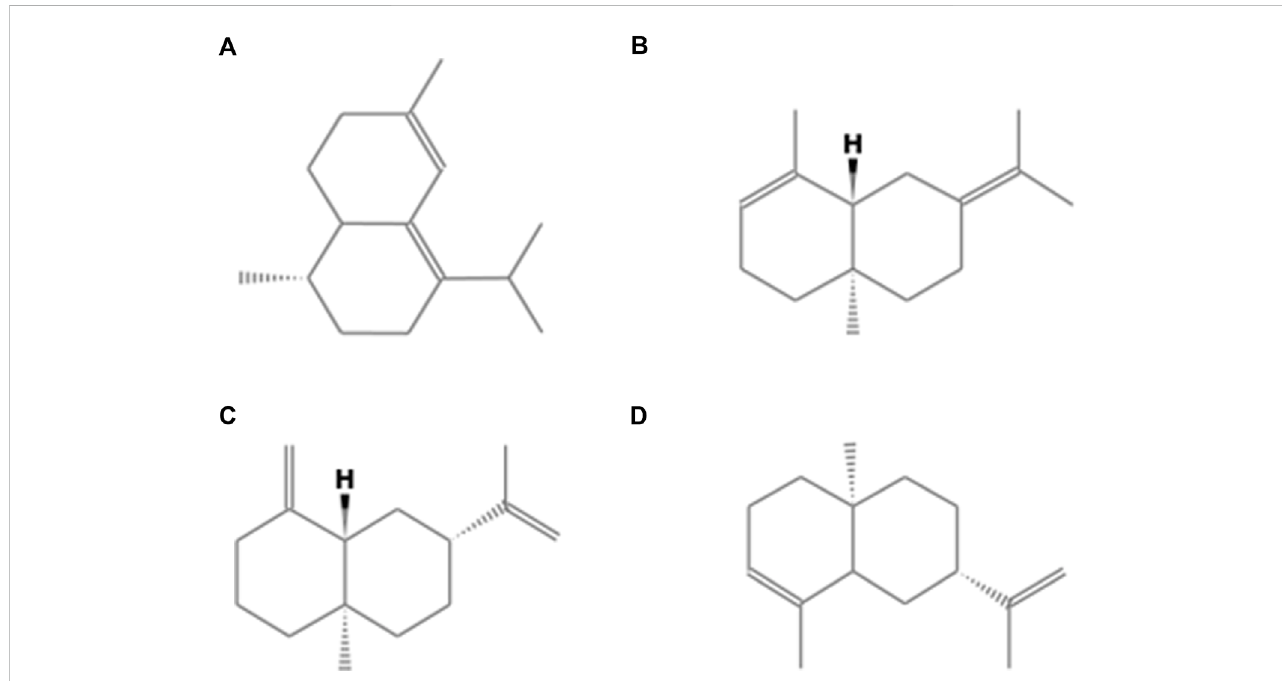
Chemical structures of major compounds from Neomitranthes obscura essential oil. (A) zonarene, (B) seline-3,7 (11)-diene, (C) β -selinene, and (D) α - selinene.